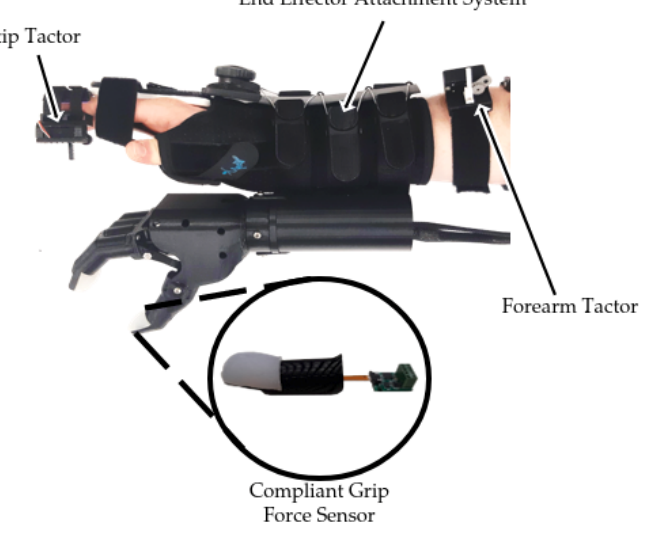
Figure 1. Modular simulated prosthesis adapted from